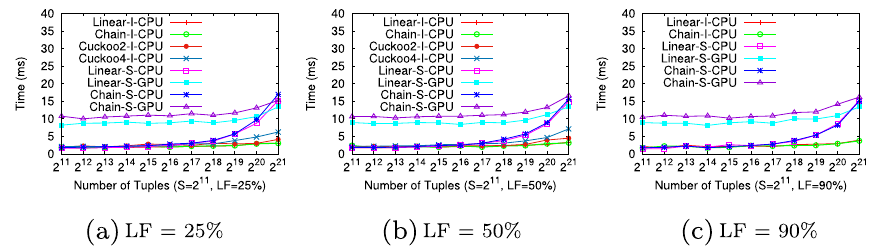
Fig. 8 Performance as the number of tuples changes with different load factors when the number of groups is set at 2 11 * LF with the hash table size of 2